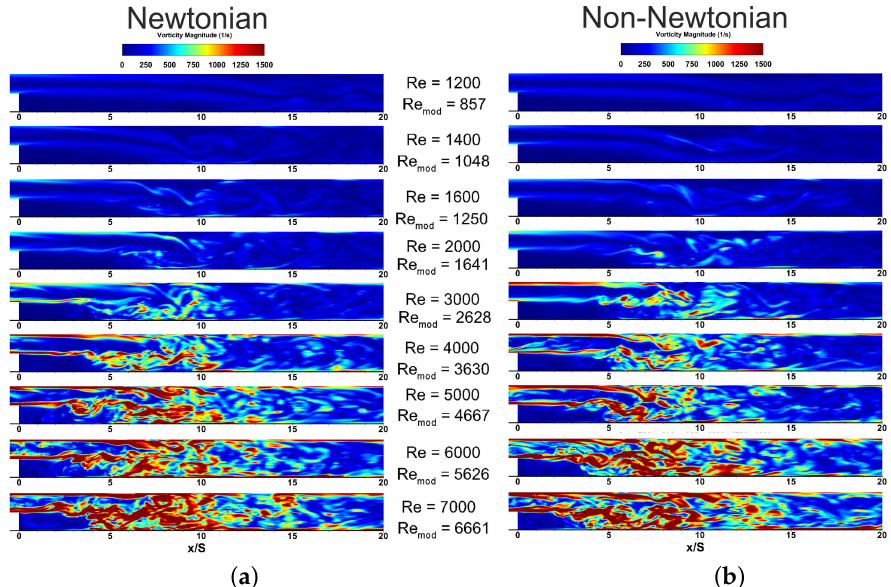
Figure 10. Instantaneous vorticity magnitude contours for Newtonian blood rheology ( a ) and shear-thinning blood rheology ( b